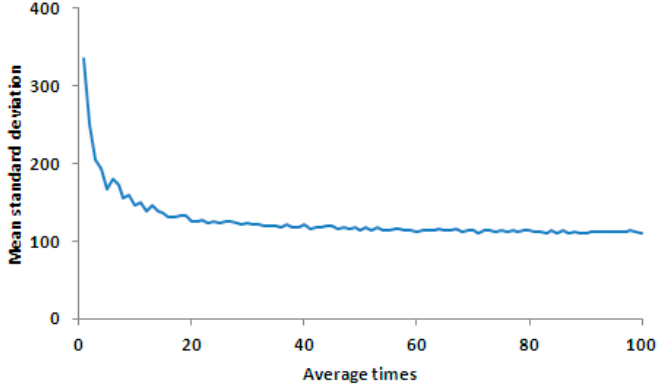
Figure 8. Mean value curve of the standard deviation of the corrected results for each line for various measurements. The horizontal axis is the average times, and the vertical axis is the precision of correction result (mean standard deviation).